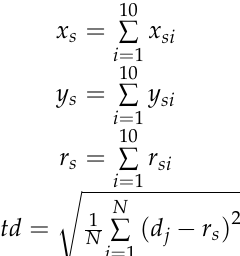
Figure 6. Contour detection process.